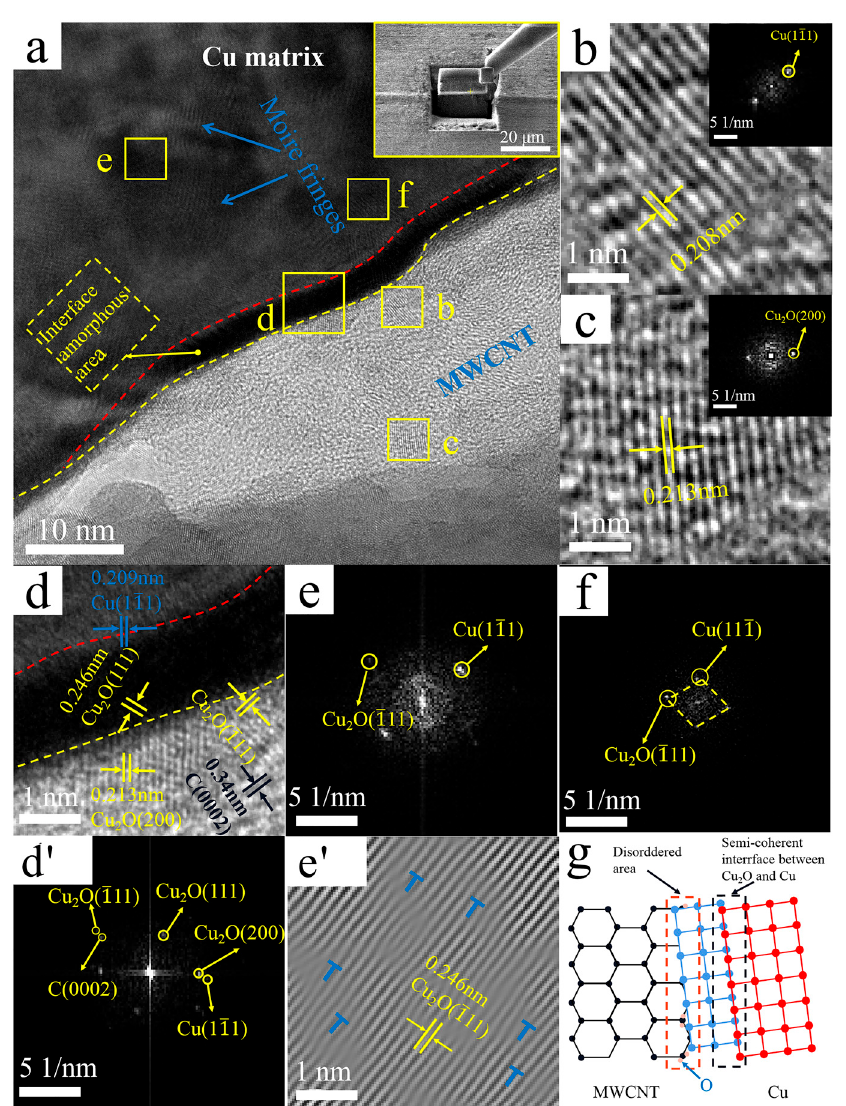
Figure 6. TEM images of the Cu@CNTs/Cu composite: ( a ) interface, upper right corner illustration shows manipulator sampling (Illustration is TEM sampling location); ( b ) enlarged view of region b in ( a ) (The illustration is the corresponding FFT image); ( c ) enlarged view of region c in ( a ) (The illustration is the corresponding FFT image); ( d , d’ ) enlarged views and FFT image of region d in ( a ); ( e , e’ ) FFT image and IFFT image of region e in ( a ), with dislocations marked by “T” symbols; ( f ) FFT image of region f in ( a ); ( g ) interface schematic.